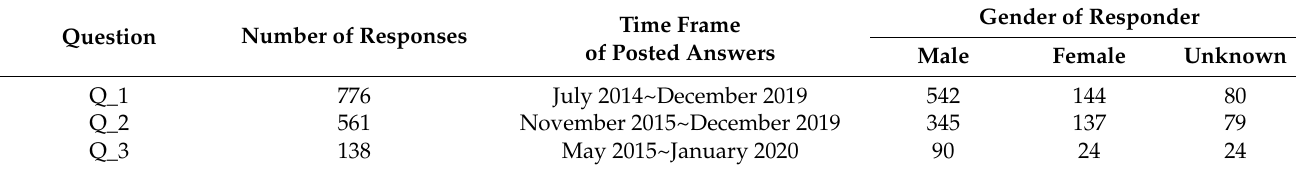
Table 3. Basic information on responses to the three questions about LBC.